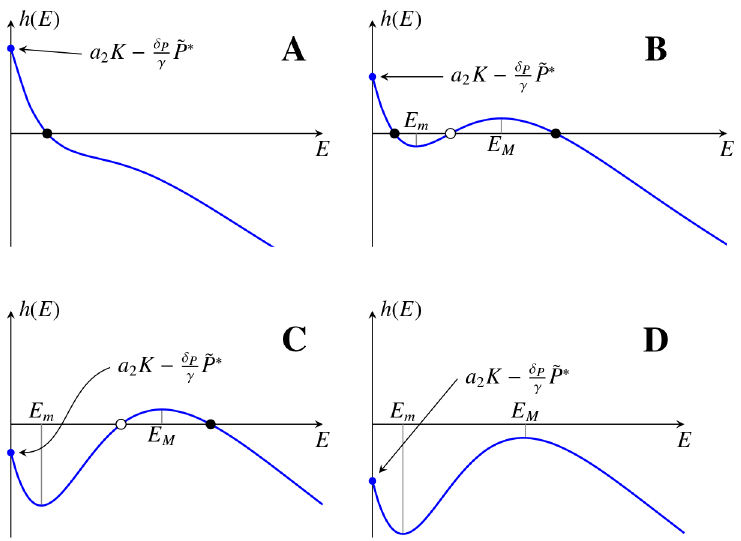
Fig 2. Possible stable morphologies of a vascular tumour. Different possible shapes of the function h , which zeros determine the coordinates of positive steady states of systems (13), (14) and (16). The of the steady states are indicated with black circles (stable states) or white circles (unstable coordinates E C i states). E M and E m indicate the values at which h reaches its local maximum and